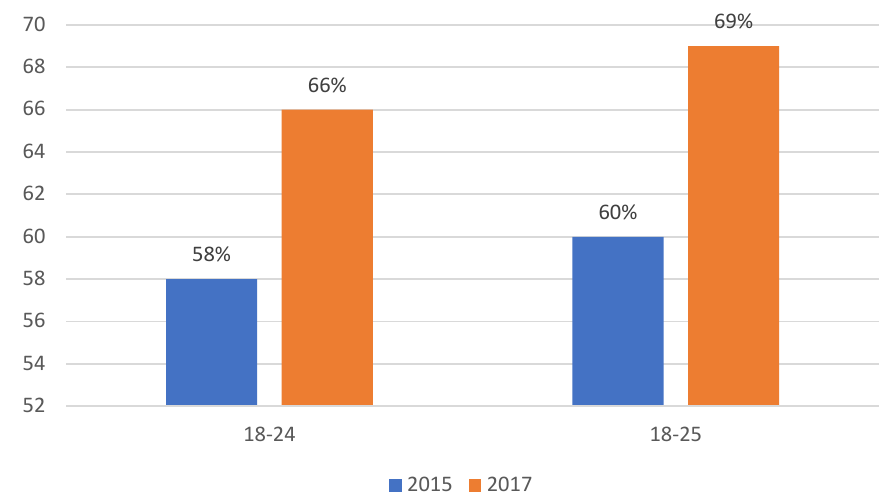
Figure 2. Understanding Society estimates of youth turnout in the 2015 and 2017 general elections. Source: Sturgis and Jennings [31].